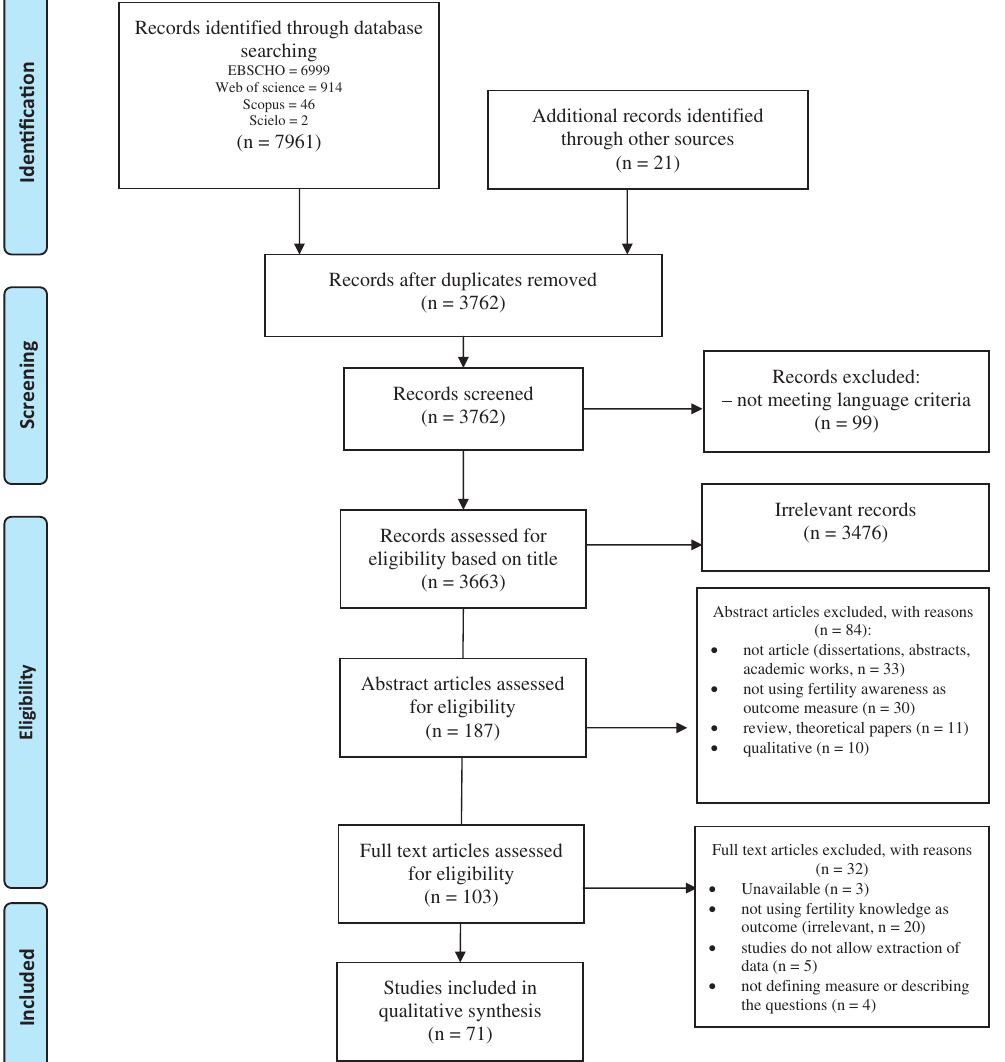
Figure 1. PRISMA flow diagram. From Moher et al., 2009